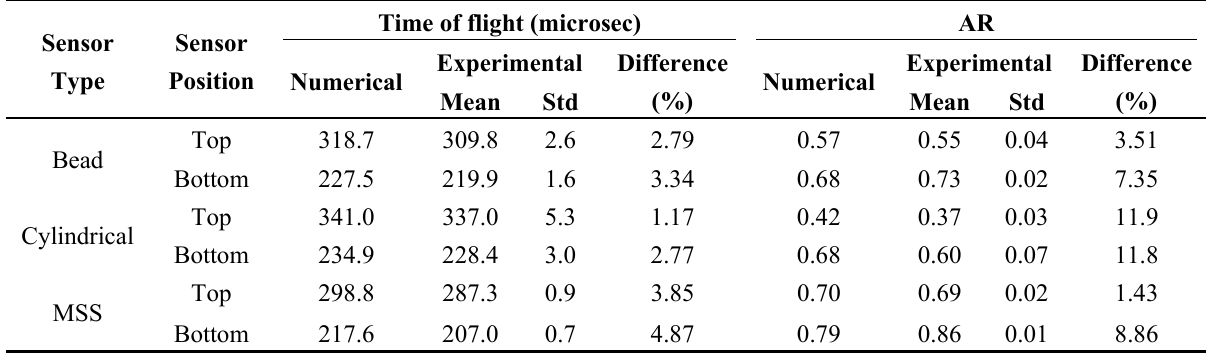
Table 2. Experimental and numerical time-of-flight and amplitude ratio.